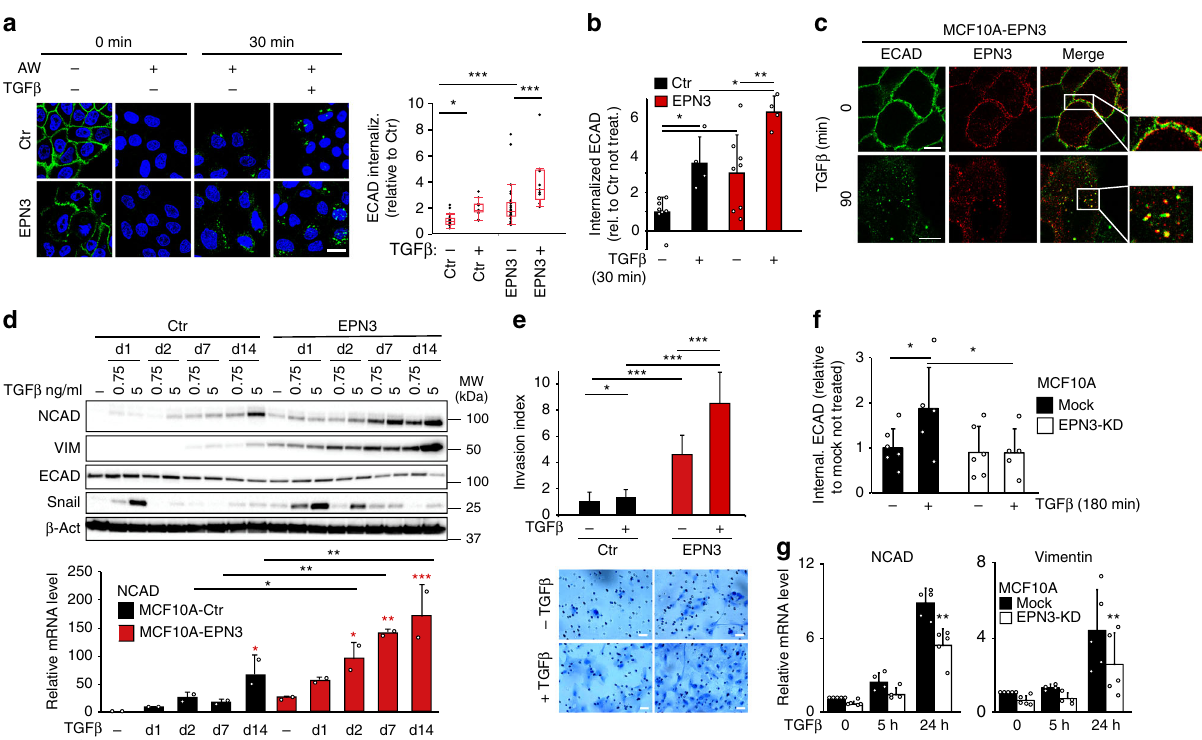
Fig. 5 EPN3 is involved in TGF β -induced ECAD internalization and TGF β signaling. a Left, ECAD internalization assay by IF in the indicated cells using an anti-ECAD Ab against the extracellular domain internalized for 30 min − / + TGF β (5 ng ml − 1 ). Cells were subjected or not to an acid wash (AW) to remove the ECAD Ab from the PM, prior fi xation. Bar, 20 µ m. Right, box plot of relative ECAD fl uorescence intensity/ fi eld of view ( N ≥ 9). P value, each pair Student ’ s t test two-tailed. b ECAD internalization assay by FACS in the indicated cells, − / + TGF β 1 (5 ng ml − 1 , 30 min). Mean fl uorescence intensity of internalized ECAD/total ± S.D. ( n ≥ 4) is reported. P value, Student ’ s t test two-tailed. c Representative co-localization images of EPN3 (red) and ECAD (green), during ECAD internalization as in ( a ). Bars, 10 µ m. d Top, lysates from the indicated cells − / + TGF β 1 (0.75 or 5ngml − 1 , for the indicated days — d) were IB with the indicated Ab. β -actin, loading control. Right, MW markers. Bottom, NCAD mRNA levels by RT-qPCR on samples − / + TGF β 1 (5ngml − 1 ). Mean relative mRNA expression vs. MCF10A-Ctr (not stimulated)±S.D. (two independent experiments, each in technical triplicates) is reported. P value, each pair Student ’ s t test, two-tailed. Black asterisks, statistical signi fi cance between each corresponding time point of EPN3 vs. Ctr; red asterisks, statistical signi fi cance between stimulated vs . not stimulated samples of MCF10A-EPN3 or -Ctr cells. e Matrigel invasion assay of the indicated cells − / + TGF β (0.75ng ml − 1 ). Top, invasion index (mean number of invading cells/ fi eld vs. control)±S.D. ( N ≥ 22). P value, Student ’ s t test two-tailed. Bottom, representative images. Bar, 50 µ m. f ECAD internalization assay by FACS analysis in MCF10A-Ctr − / + EPN3 silencing, − / + TGF β 1 (5ngml − 1 , 180min). Mean fl uorescence intensity of internalized ECAD/total±S.D. ( n ≥ 5) is reported. P value, Student ’ s t test two-tailed. g RT-qPCR analysis of NCAD and VIM mRNA levels in cells as in ( f ). Mean relative mRNA expression vs. mock-unstimulated cells±S.D. ( n ≥ 4) is reported. P value, each pair Student ’ s t test, two-tailed. Source data are provided as a Source Data fi